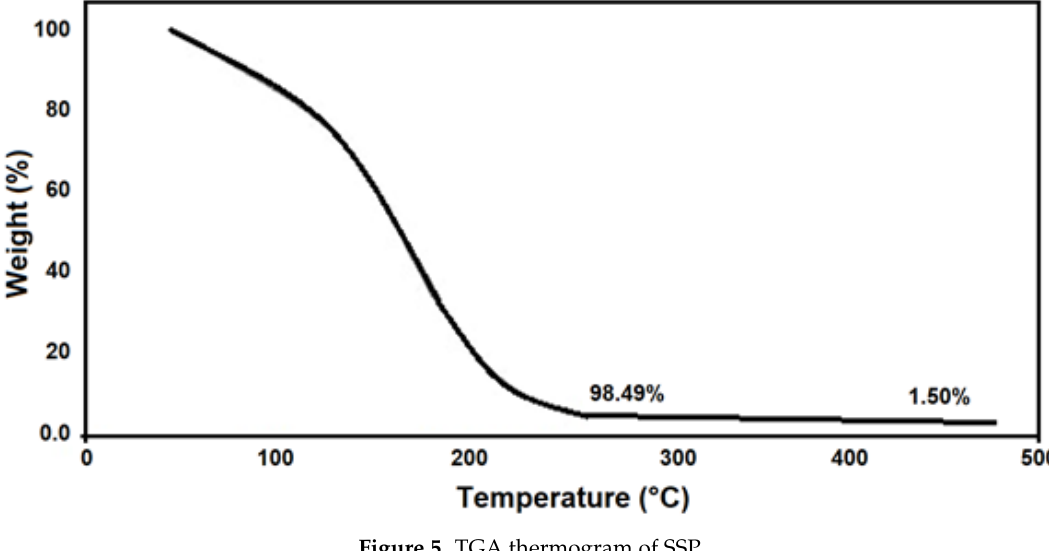
Figure 5. TGA thermogram of SSP.